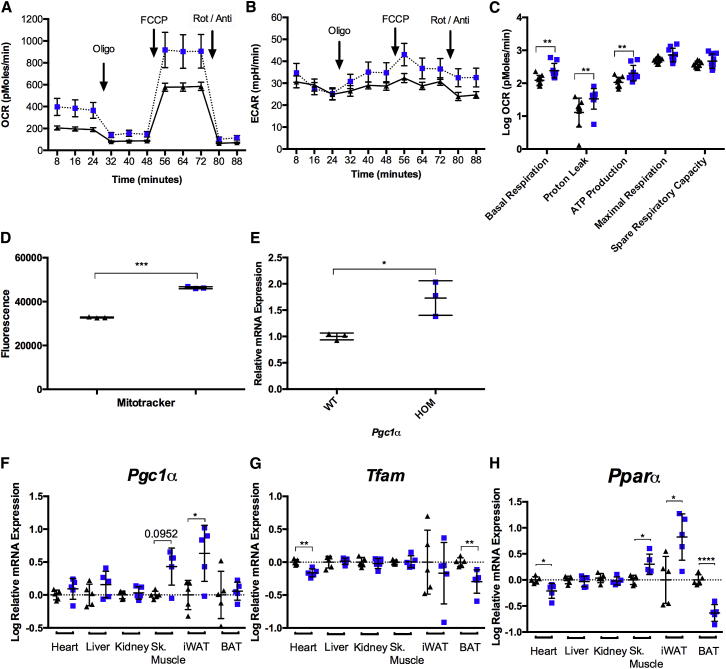
Upregulation of Mitochondrial Biogenesis Prevents Mitochondrial Respiratory Chain Dysfunction in Wars2V117L/V117L MEFs, Skeletal Muscle, and iWAT(A and B) Oxygen consumption rate (OCR) (A) and extracellular acidification rate (ECAR) (B) were measured in cultured primary mouse embryonic fibroblasts harvested from Wars2V117L/V117L and Wars2+/+ embryos using a Seahorse XF24 analyzer. OCR and ECAR measurements were taken at baseline and following oligomycin (Oligo), carbonyl cyanide 4-(trifluoromethoxy)phenylhydrazone (FCCP), and rotenone and antimycin (Rot/Anti) treatment. OCR and ECAR measurements were normalized to live cell number.(C) Relative oxygen consumption rates of basal respiration, proton leak, ATP production, maximal respiration, and spare respiratory capacity in Wars2+/+ and Wars2V117L/V117L MEF cultures. There were 9 replicates of each genotype; mean ± SD. Data were log transformed and analyzed using an unpaired two-tailed t test or a Mann-Whitney t test.(D) MEFs were stained with MitoTracker green, and fluorescence in 30,000 cells per sample was quantified by fluorescence-activated cell sorting (FACS). There were 3 replicates of each genotype; mean fluorescence ± SD. Data were analyzed using an unpaired t test.(E) Relative mRNA expression analysis of Pgc1α in Wars2+/+ and Wars2V117L/V117L MEF cultures. There were 3 replicates of each genotype; mean fluorescence ± SD. Data were analyzed using an unpaired t test.(F–H) Relative mRNA expression analysis of (F) Pgc1α, (G) Tfam, and (H) Pparα in tissues harvested from Wars2V117L/V117L and Wars2+/+ male mice at 12 months of age. Wars2V117L/V117L and Wars2+/+ animal numbers were 5 and 5, respectively; mean ± SD. Data are shown as log transformed and analyzed using an unpaired two-tailed t test or a Mann-Whitney t test (skeletal muscle and iWAT for Pgc1α).∗p < 0.05, ∗∗p < 0.01, ∗∗∗p < 0.001, ∗∗∗∗p < 0.0001. Wars2V117L/V117L mice are blue squares, and Wars2+/+ mice are black triangles.